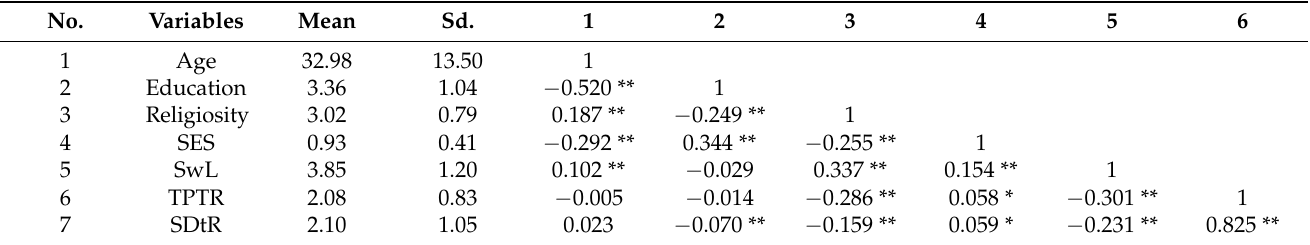
Table 3. Correlations